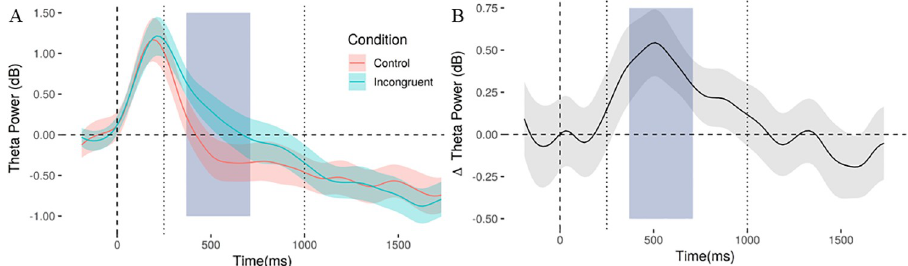
Fig 2. Theta power (4–8 Hz) calculated from mid-frontal electrodes (Fz, Cz, FCz) as a function time (0 = image onset) for (A) the incongruent and control conditions separately, and (B) as the difference between the two conditions. The dotted vertical lines indicate the time window used for the analysis (250–1000 ms), while the grey area show the interval (370–710 ms) in which the two conditions significantly differ after multiple comparison correction. The shaded areas around the lines represent the standard error of the